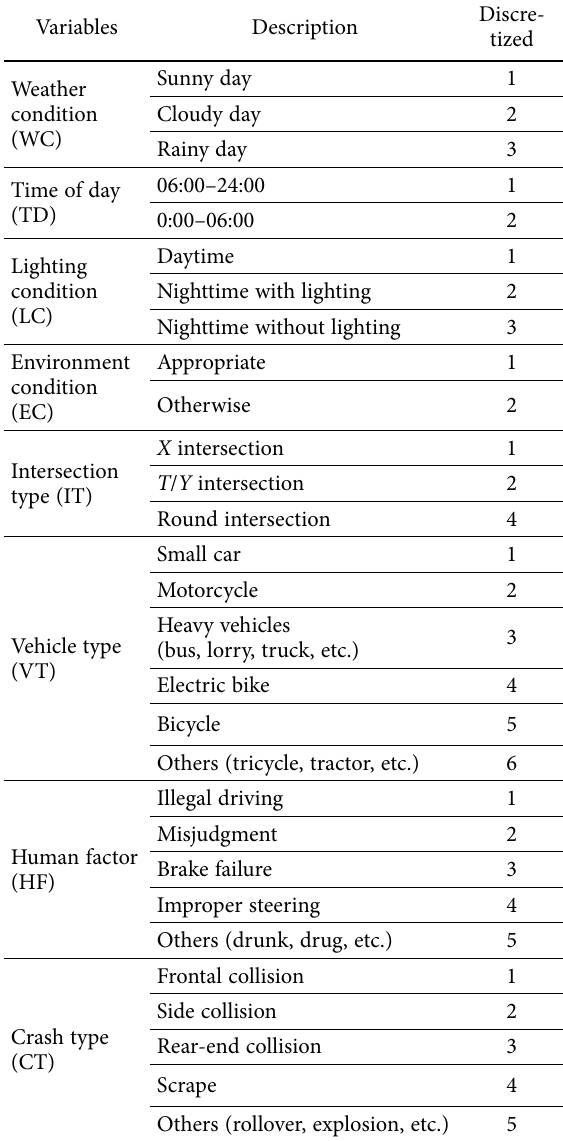
Table 1. Utilized variables and their discretized results